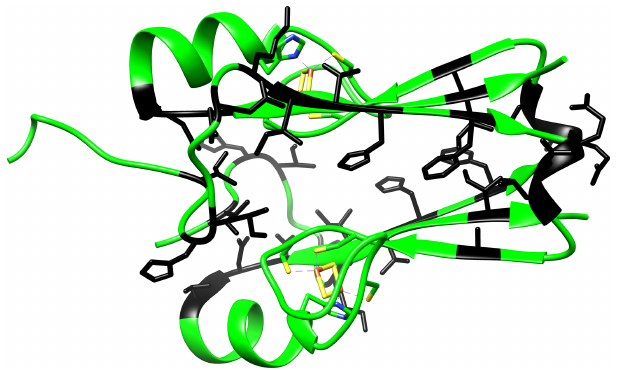
Figure A2. Crystal structure of mitoNEET (2QD0). Residues ex- periencing the higher changes in the NH chemical shifts in the two different redox states as identified in the HSQC spectra are colored in